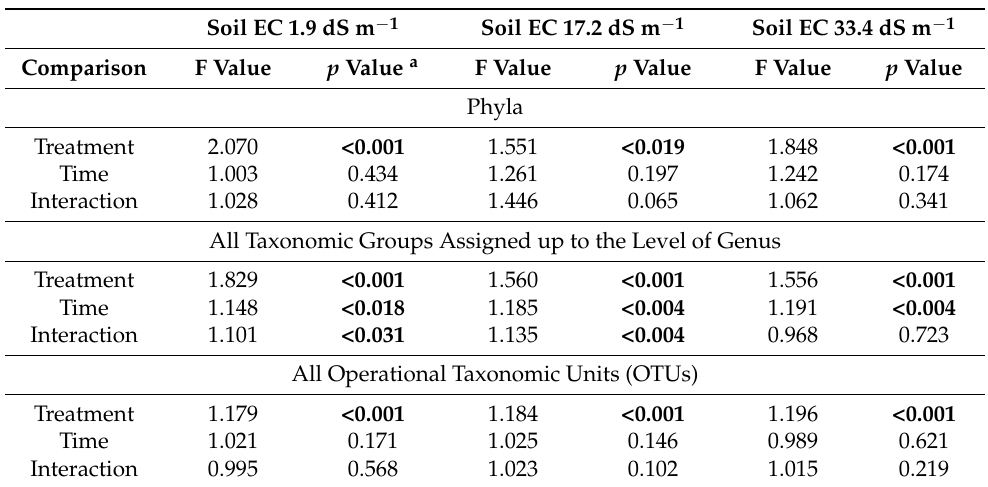
Table 3. The effect of treatment (unamended, young maize plants amended soil or neutral detergent fibre amended soil), time (one, three, seven, and 14 days of aerobic incubation) and their interaction on the soil bacterial community, as determined with a perMANOVA analysis with the sequence counts converted to centeredlog-ratio transformation with ALDEx2 package